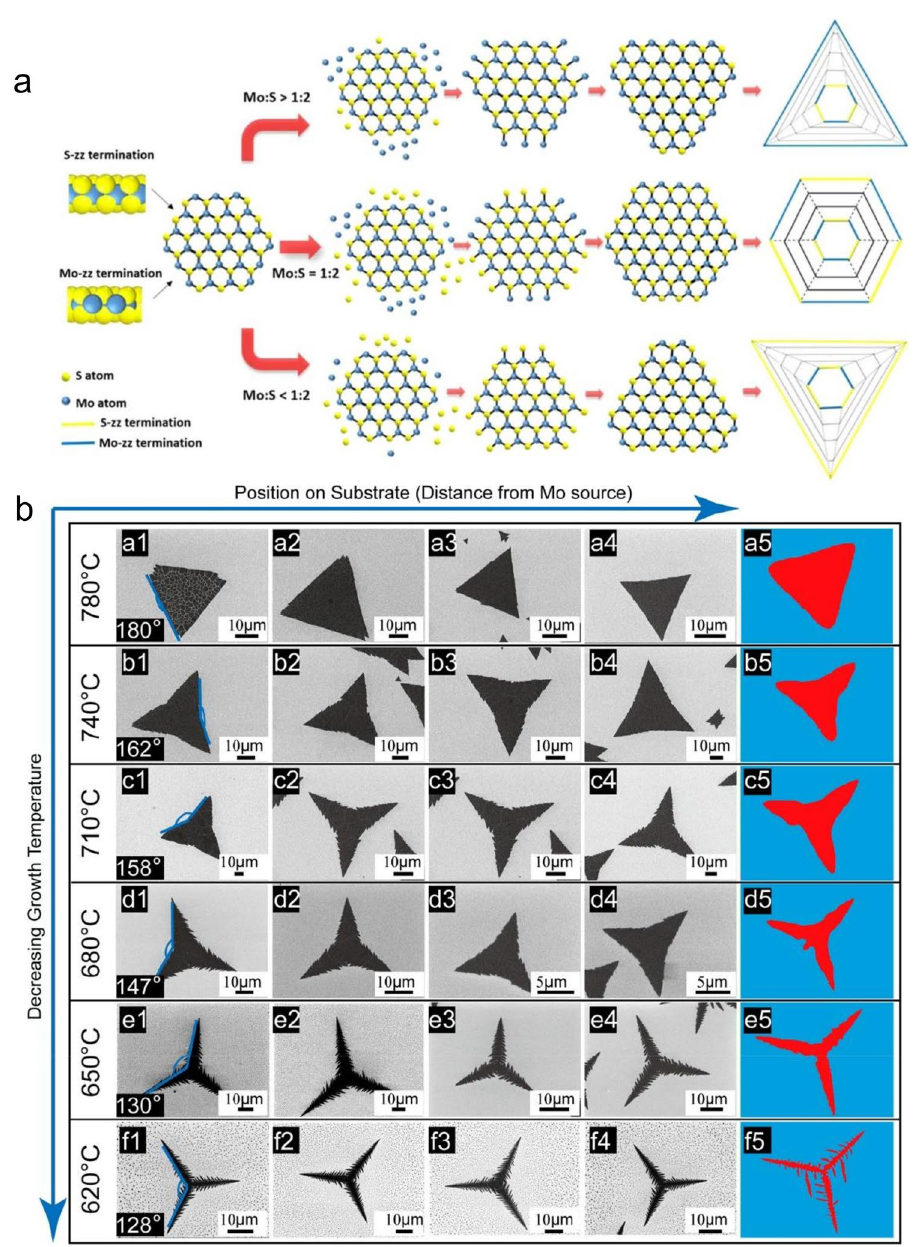
Fig. 5 The MoS 2 shape as the function of the growth condition. a Influence of Mo:S ratio [60], Copyright 2014, American Chemical Society. b Influence of growth temperature and substrate position [81], Copyright 2021, American Chemical